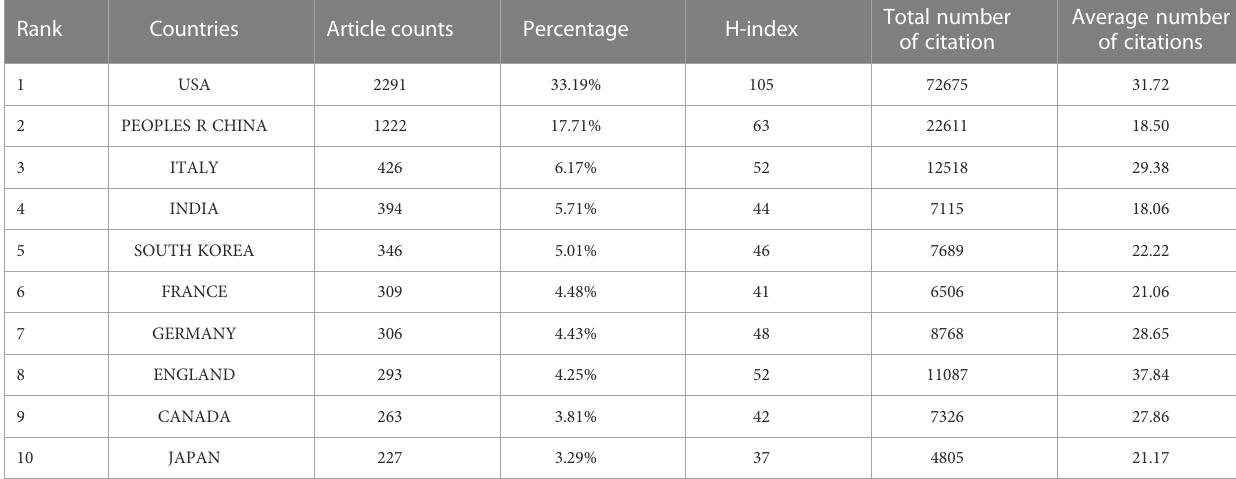
TABLE 1 The top 10 countries/regions contributing to publications about in fl ammation in breast cancer.